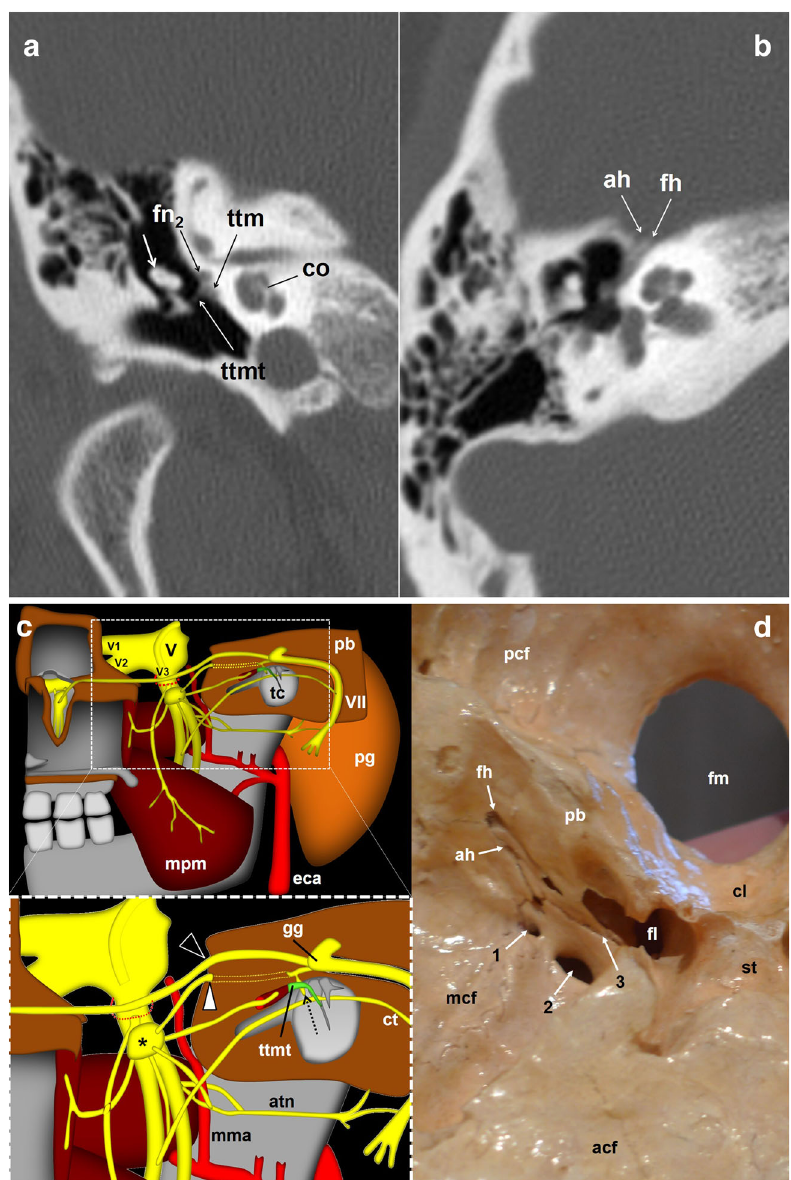
Fig. 6 The glossopharyngeal nerve (gpn) and the tympanic nerve of Jacobson. a Skull base CT scan; coronal reconstruction of the right temporal bone, bone window. Once arriving at the tympanic cavity at the level of the promontory (p), the tympanic nerve forms a submucous plexus withinthe middle earincludingthemastoidantrumandEustachiantube. At the level of the tendon(ttmt)ofthe tensortympani muscle(ttm),a branchof the tympanic plexus exits the cavity through a small duct and courses forward next to the facial nerve (fn 2 ); short white arrow: malleus; co: cochlea. b Skull base axial CT scan; right temporal bone, bone window. The glossopharyngeal nerve fibres will exit the petrosal bone through the accessory hiatus (ah) after joining the lesser petrosal nerve of the facial nerve. fh: fallopian hiatus. c Schematic drawing of the right infratemporal fossa, view from inside. Glossopharyngeal nerve relationships with the facial (VII) and trigeminal (V) nerves. The lower drawing represents a detailed view of the region of interest (dashed rectangle). The deep great petrosal nerve (dotted arrow) comes up from the tympanic plexus at the level of the tendon of the tensor tympani muscle (ttmt) to merge with the